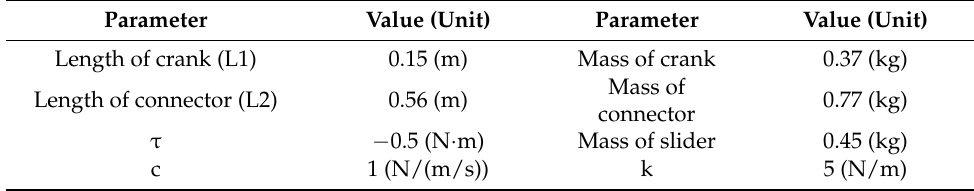
Table 1. Parameters of the crank slider mechanism.